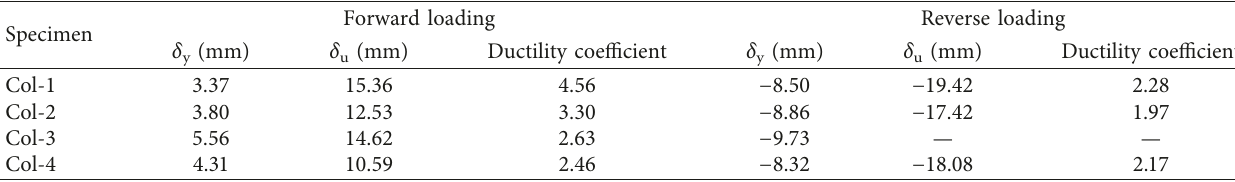
Table 3: Summary of horizontal displacement at the column top under typical horizontal load and ductility coefficient. Specimen